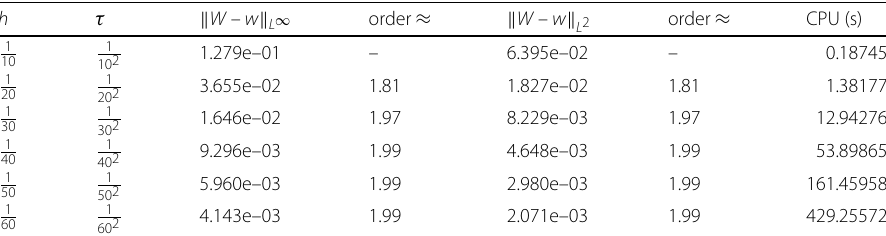
Table 2 Errors and computational orders of central difference scheme for W